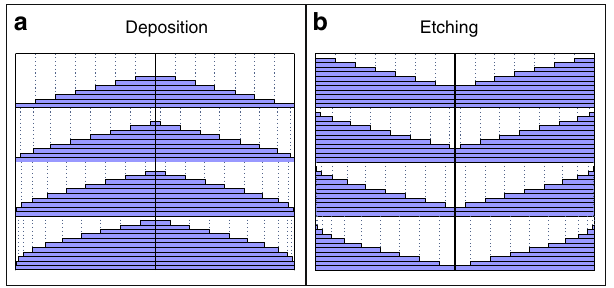
Fig. 3 Zeno Effect: Shape evolution of the mounds formed during deposition ( a ) and etching ( b ), due to the Zeno Effect 18 –